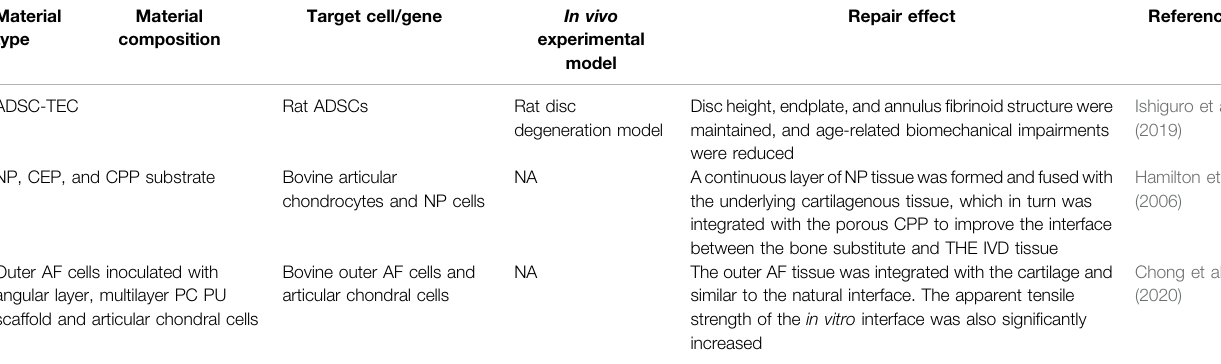
TABLE 3 | Summary of various biomaterials for cartilage endplate repair and their